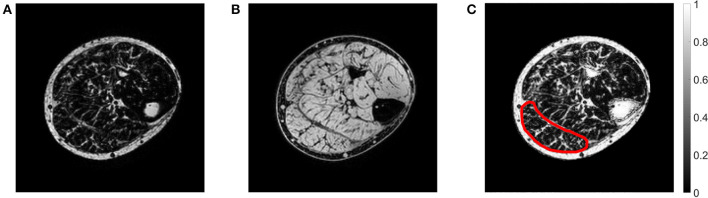
Example of an axial mDixon image from the paretic leg of a stroke patient showing the (A) fat-saturated image, (B) water-saturated image, and (C) fat fraction map. In the fat fraction map, voxels with high fat fractions are white and voxels with low fat fractions are black. The slice is approximately midway between the ankle and the knee. The medial gastrocnemius muscle boundary has been outlined.